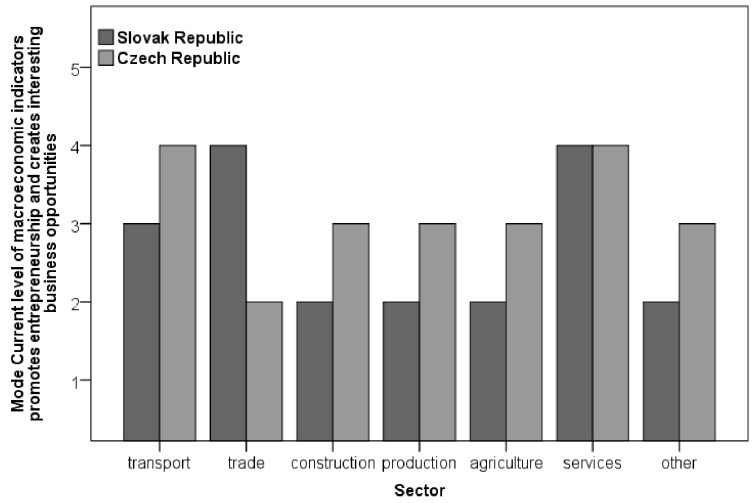
Figure 4. Current level of macroeconomic indicators promotes entrepreneurship and creates interesting business opportunities In the following lines, the differences revealed by correspondence analysis between re- sponses of entrepreneurs from the Slovak Republic and the Czech Republic in four state- ments, which form Macroeconomic environment construct of questionnaire, are